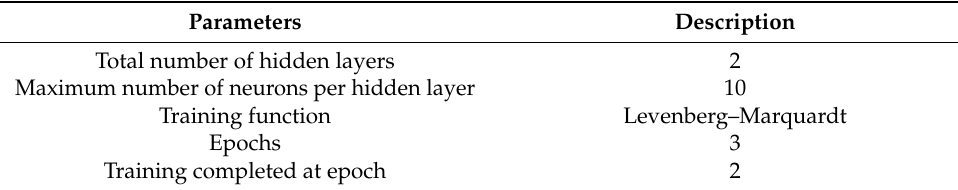
Table 4. Parametric adjustment of the developed model. Table 4 . Parametric adjustment of the developed model . Parameters